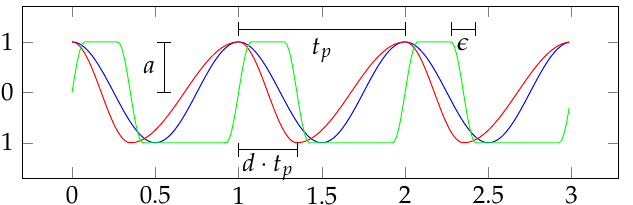
Figure 2. Cosine (blue), composite cosine p coscomp ( t ) (red) and smoothed square wave p ssqw ( t ) (green, with larger (cid:101) for